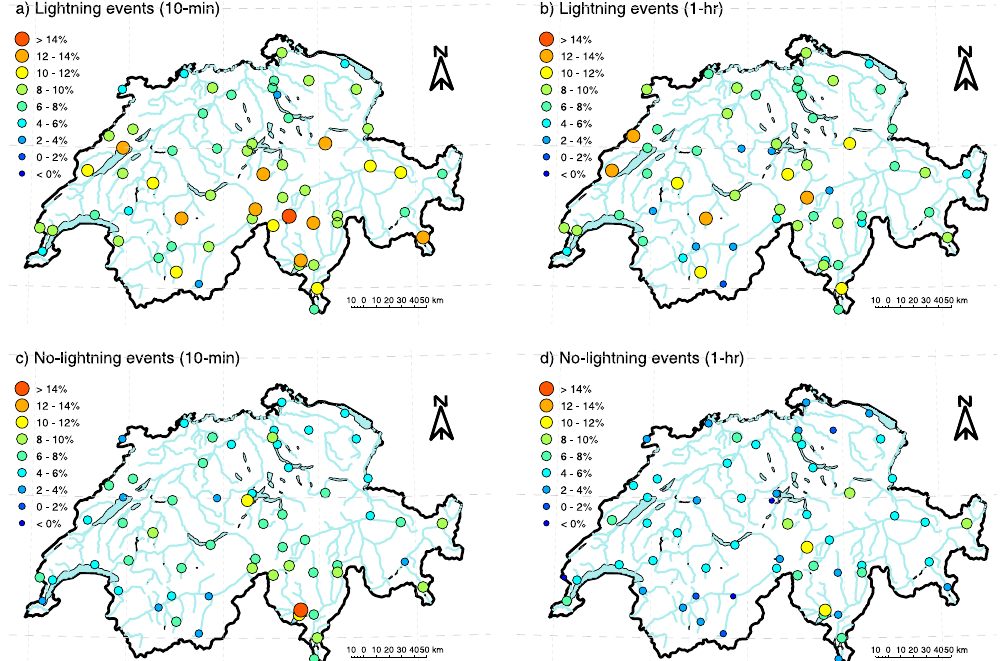
Figure 8. Spatial maps of scaling slopes for mean event intensity I m for lightning events at the (a) 10min and (b) 1h resolutions, and no-lightning events at the (c) 10min and (d) 1h resolutions for the 95th percentile estimated with the quantile regression method. The colour and size of the legend markers indicate the scaling slope magnitude in % ◦ C − 1 . The same figure for the temperature binning method is in the